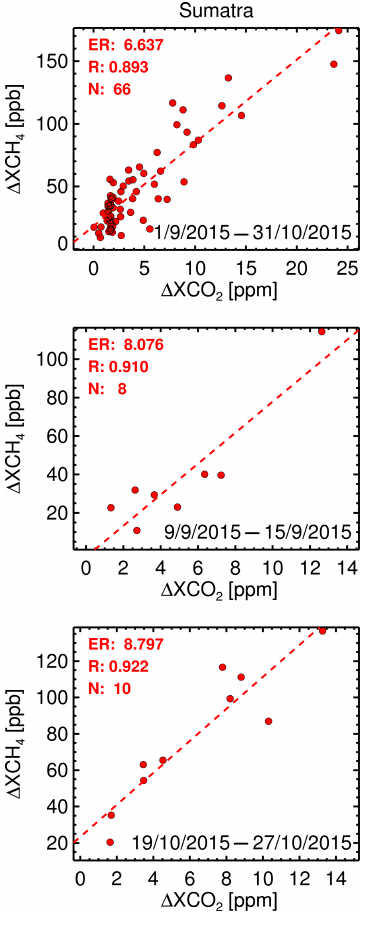
Figure 9. Scatterplots of (cid:49) XCH 4 vs. (cid:49) XCO 2 derived for Sumatran large-scale fire plumes via analysis of TANSO-FTS data for the time periods detailed in Fig. 8: September–October 2015 (top), Period 1: 9–15 September (middle) and Period 2: 19–27 October (bottom). The CH 4 / CO 2 ER is calculated as the gradient of a linear fit to the data (dashed line). The correlation coefficient R and the number of soundings N are also